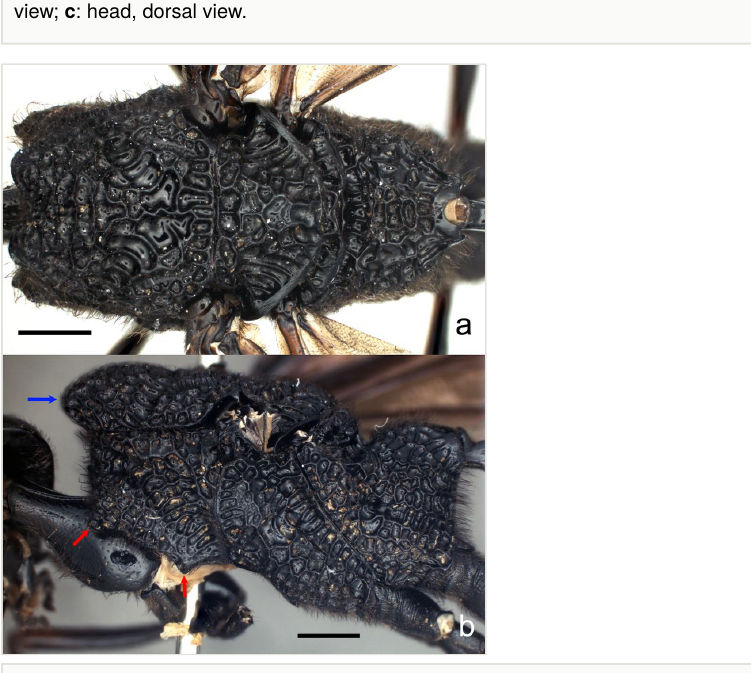
Figure 3. Pristaulacus emarginaticeps male. Scale bars 1.0 mm. a : mesosoma, dorsal view; b : mesosoma, lateral view. (Blue arrow shows the mesoscutal prominence and red arrows show tooth-like